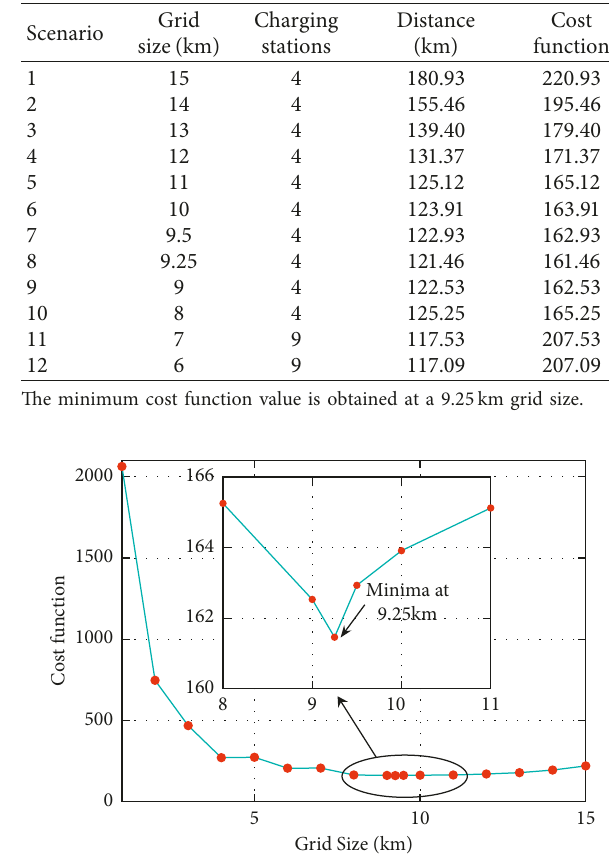
Figure 9: Methodology of the proposed algorithm for optimal routes. Table 1: Total distance and the calculated cost function.